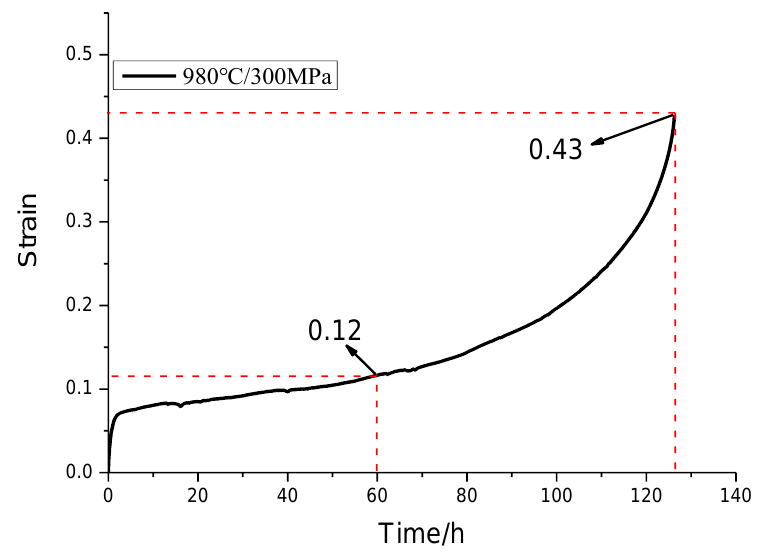
Figure 8. Creep curve of 3-mm specimen at 980 °C/300 MPa.